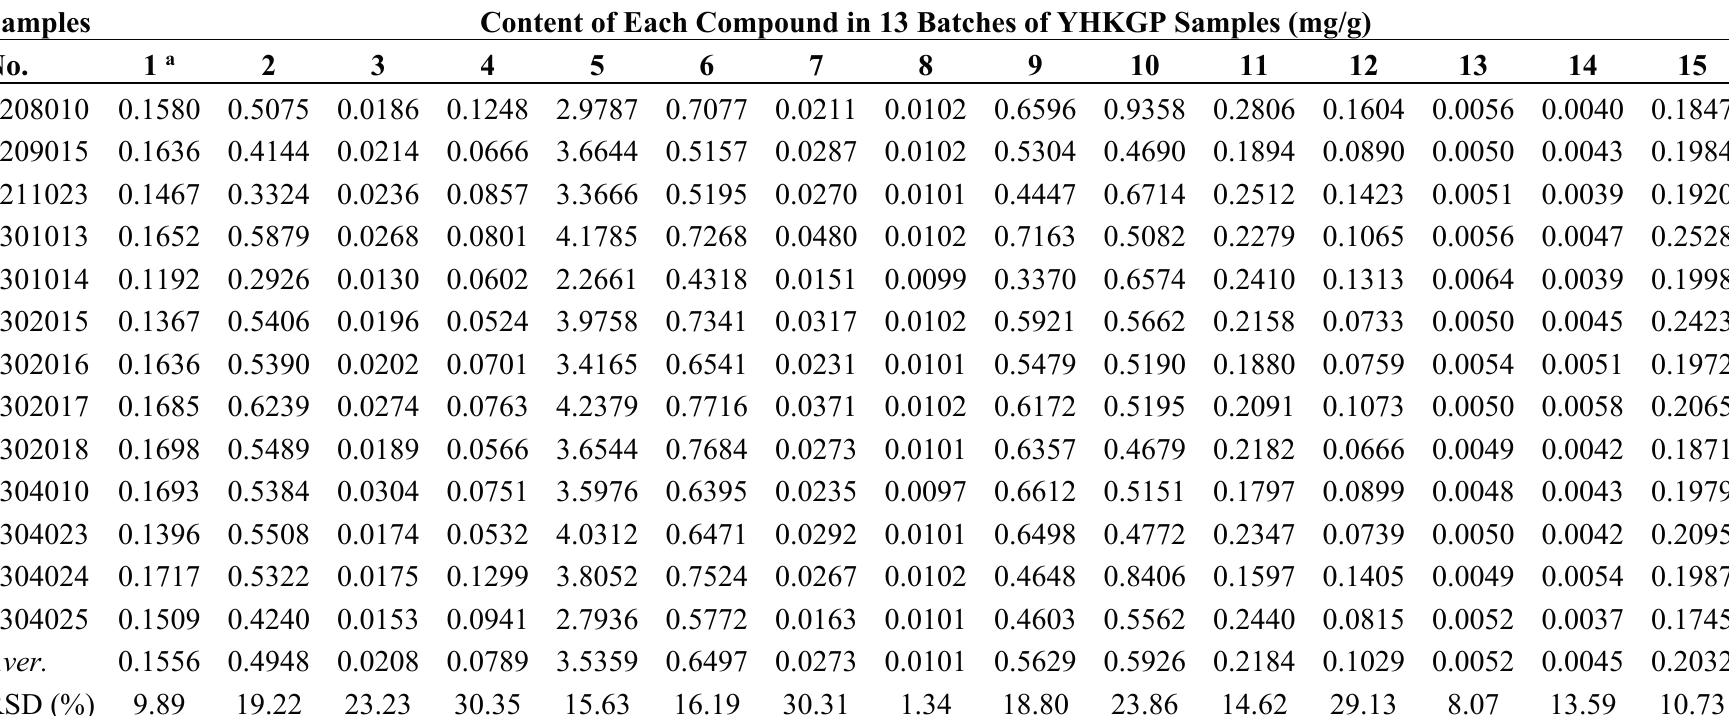
Table 4. Contents of 29 investigated compounds in 13 batches of YHKGT